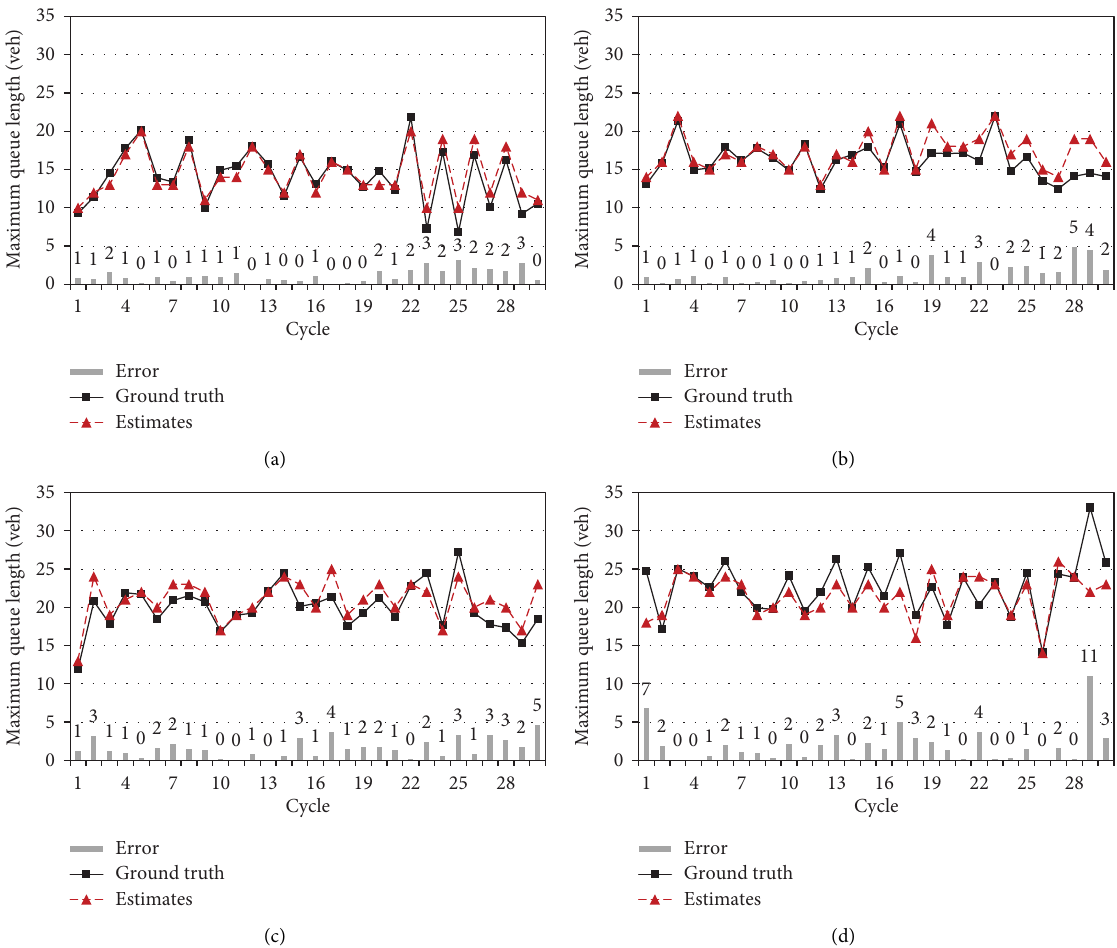
Figure 10: Cycle-based estimates under diferent d / c values. (a) d / c � 0.4. (b) d / c � 0.6. (c) d / c � 0.8. (d) d / c � 1.0.